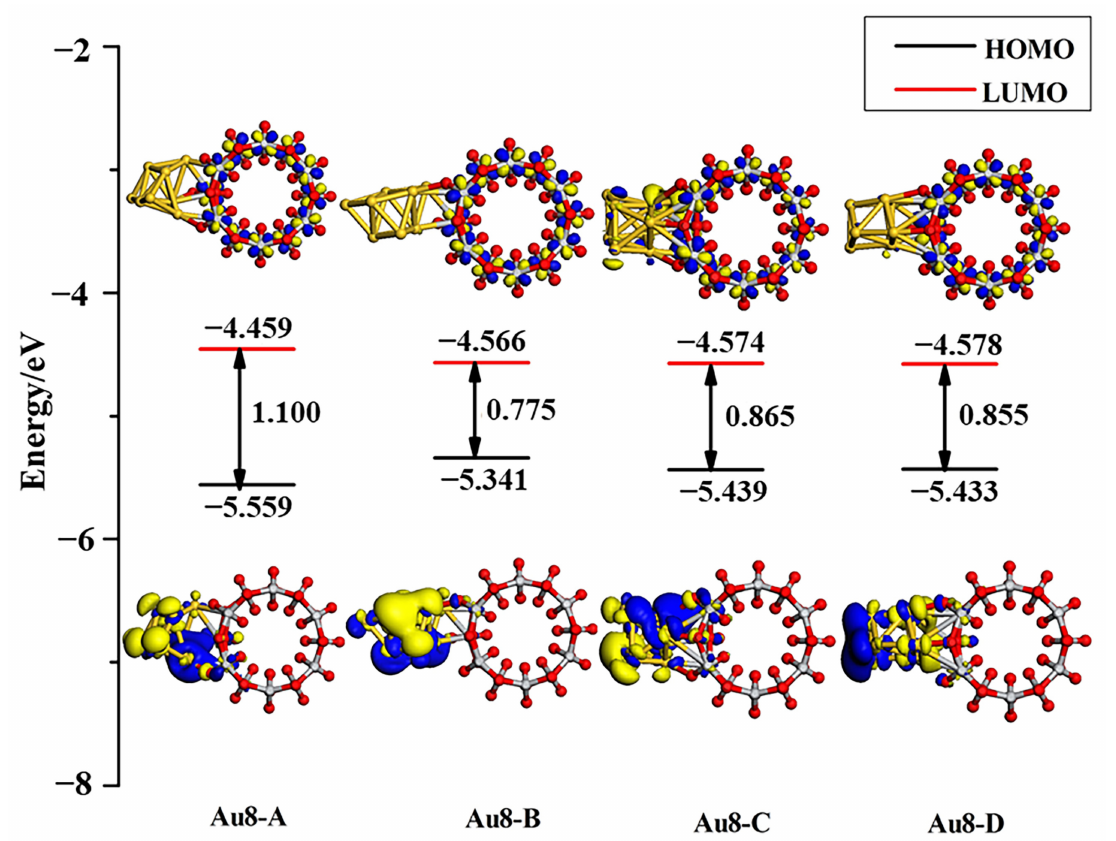
Figure 8. HOMO and LUMO along with the energy gap of four Au 8 adsorption systems calculated at the Γ -point. The isovalue set is 0.025 electrons/Å 3